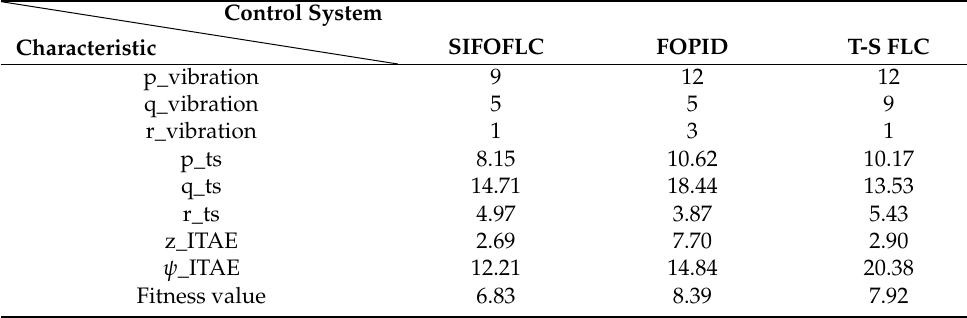
Table 4. Quantitative analysis of system